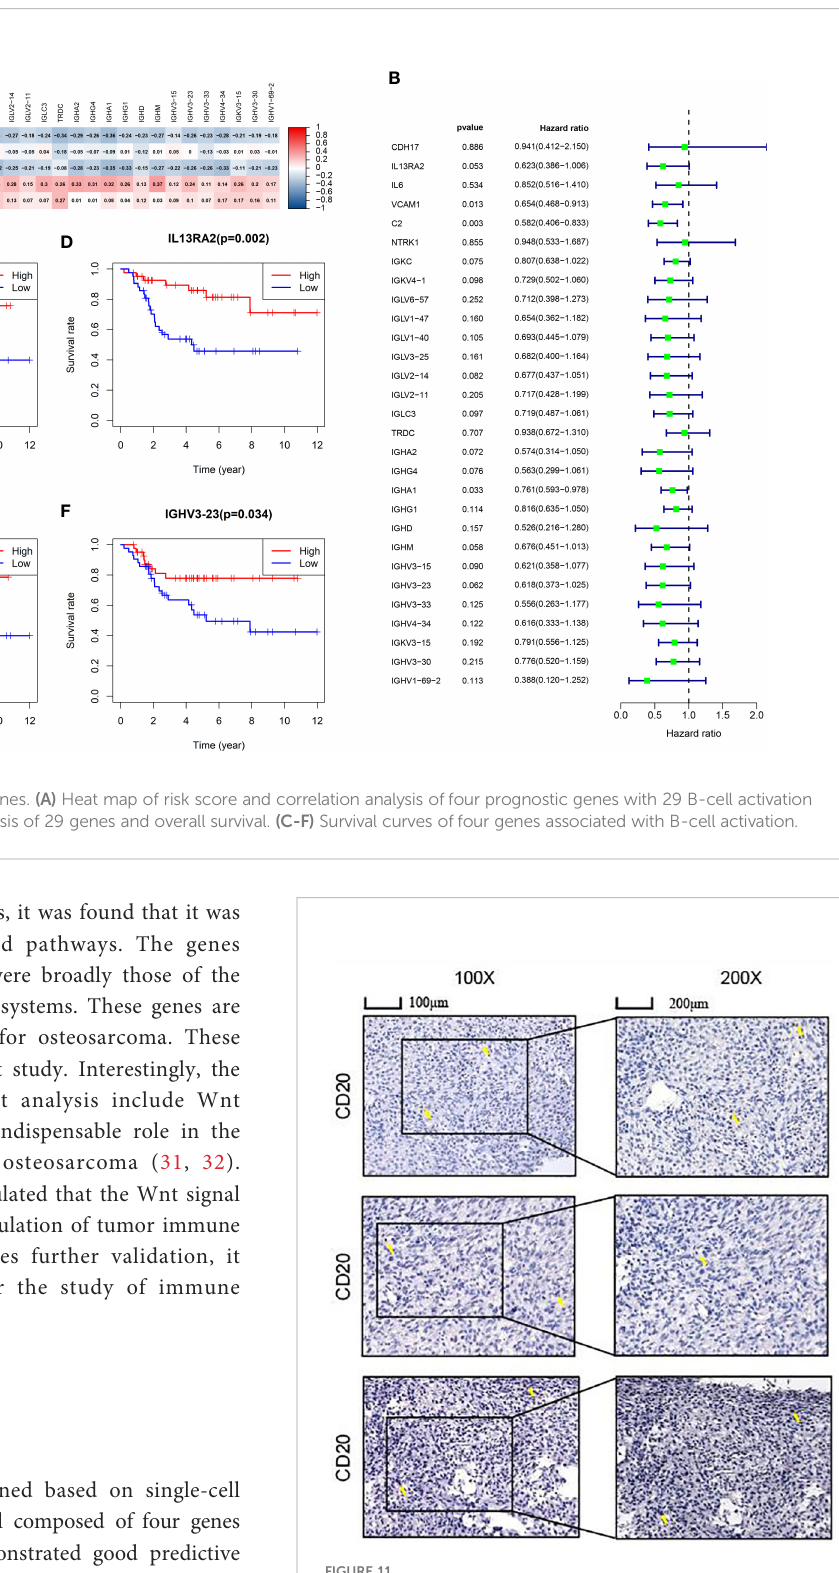
FIGURE 11 Immunohistochemistry (IHC) staining of OS using anti-CD20 antibody